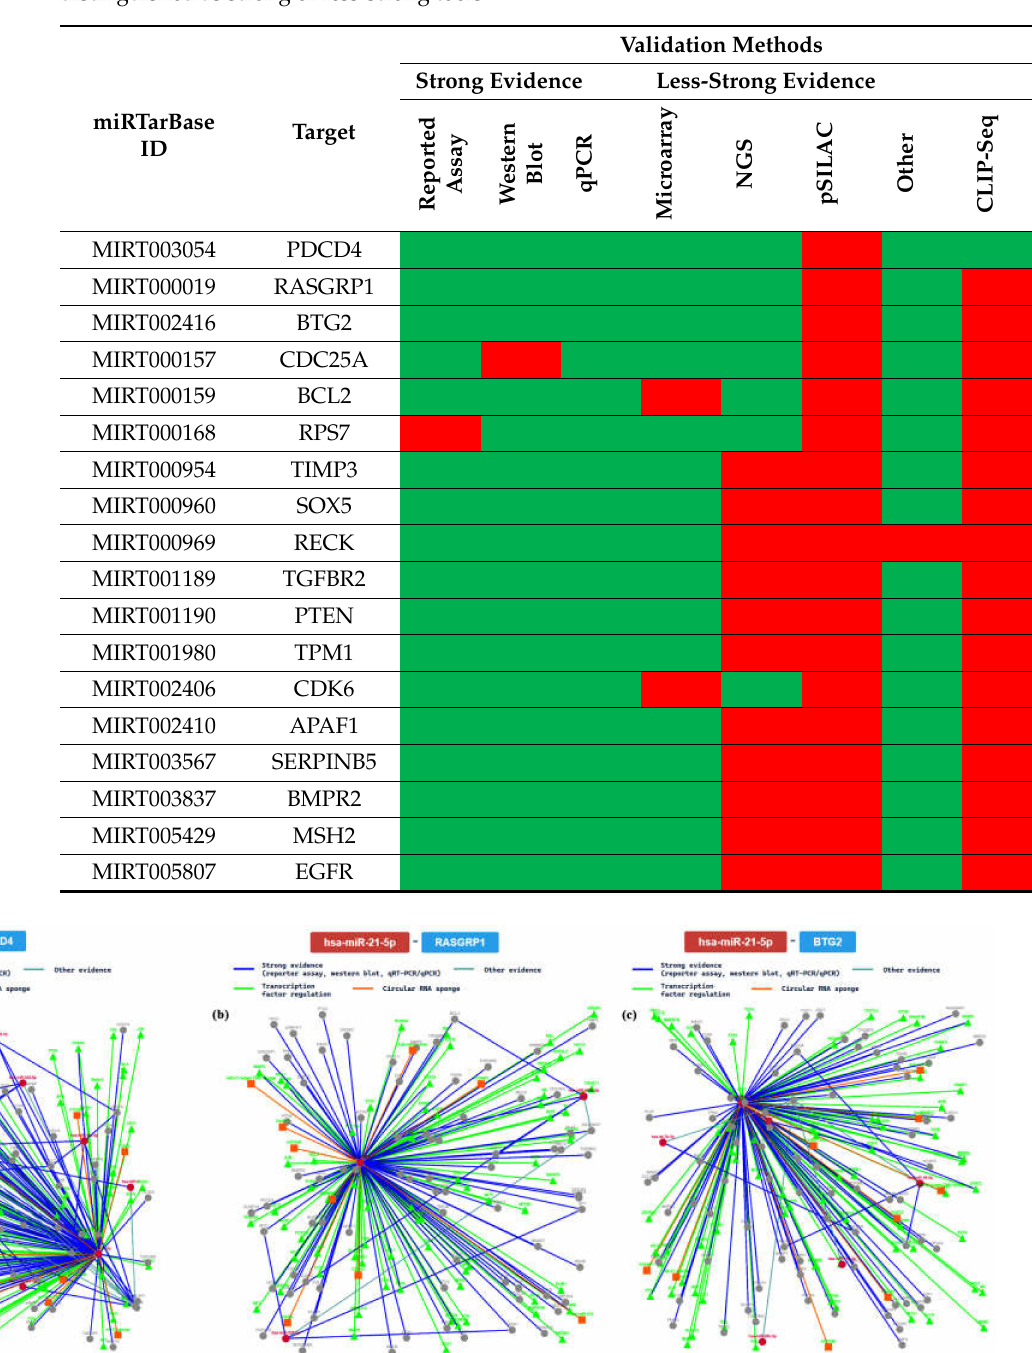
Table 4. Summary of the miRNA interactions referred to hsa-miR-21, supported with at least 6 positive tools; green = validated methods, red = unvalidated methods. The methods have been distinguished as strong or less-strong tools.